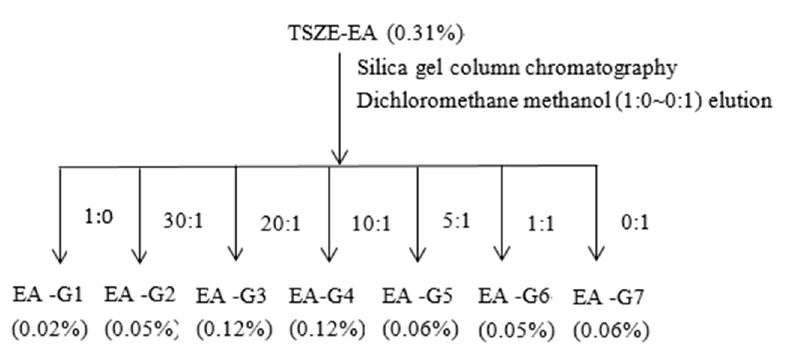
Figure 8. Preparation process of elution components in TSZE-EA.